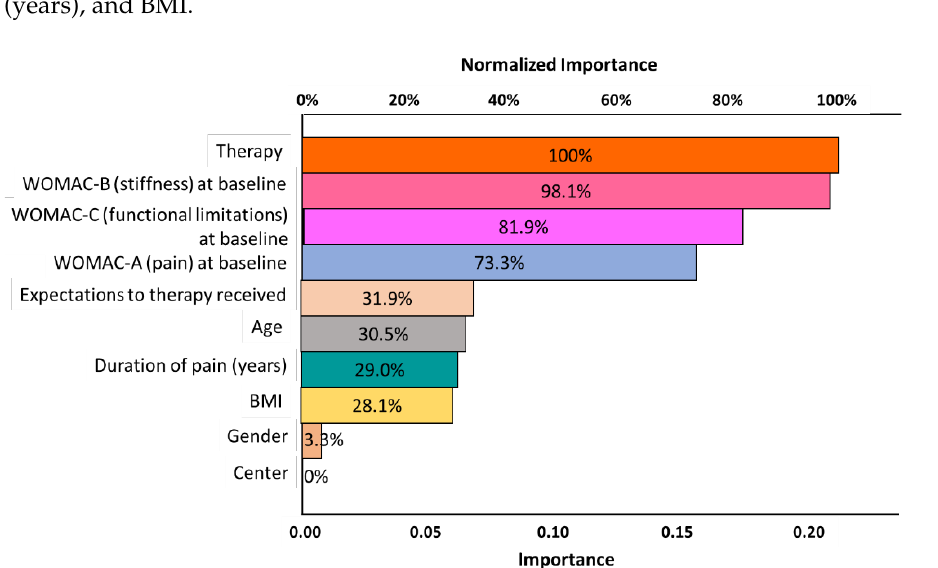
Figure 3. Results of the radial basis function network showing importance and normalized importance of various independent variables for the dependent-variable changes in the WOMAC Index from baseline to 12 weeks.